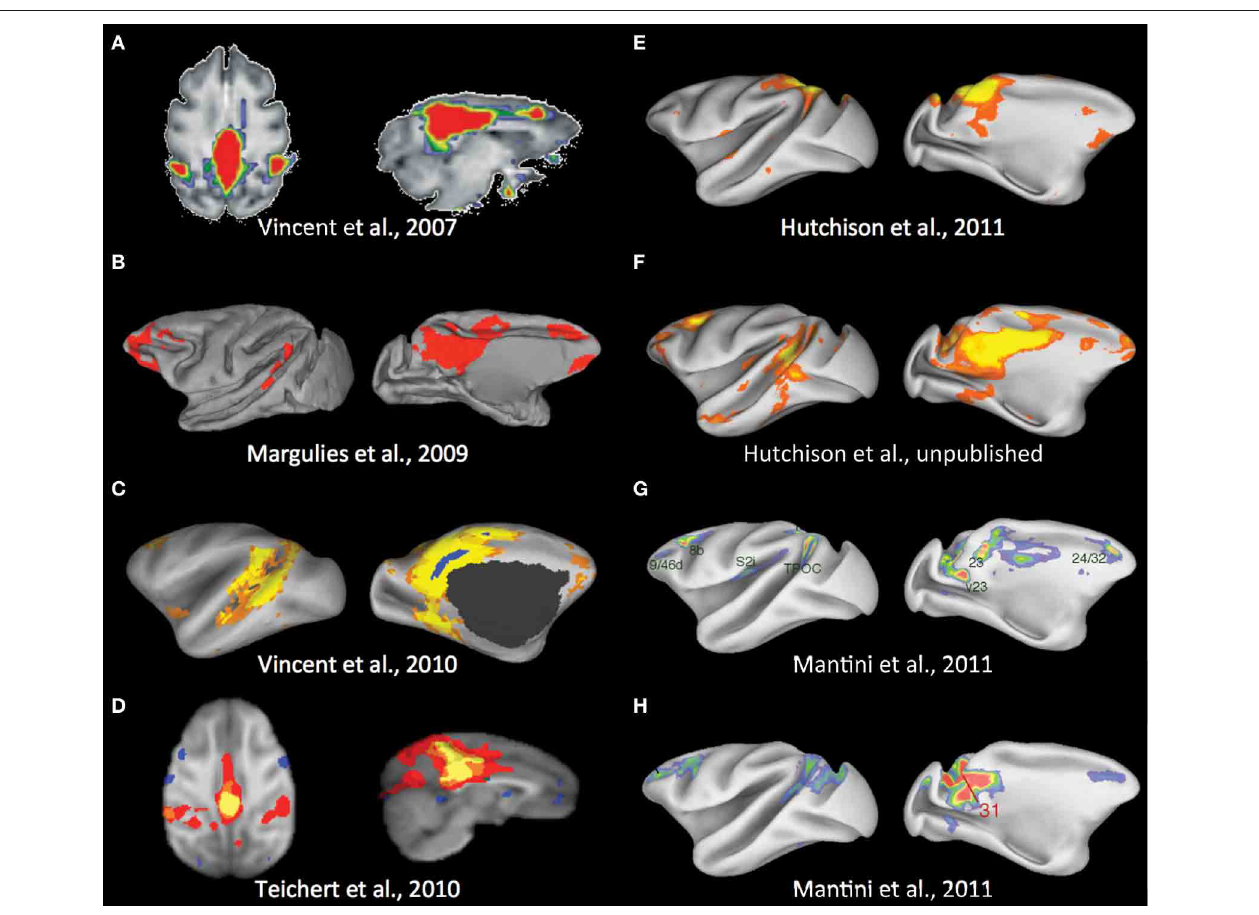
FIGURE 3 | Potential default-mode network homolog of the macaque across multiple studies. See text for description. Modified with permission from (A) Vincent et al. (2007); (B) Margulies et al. (2009); (C) Vincent et